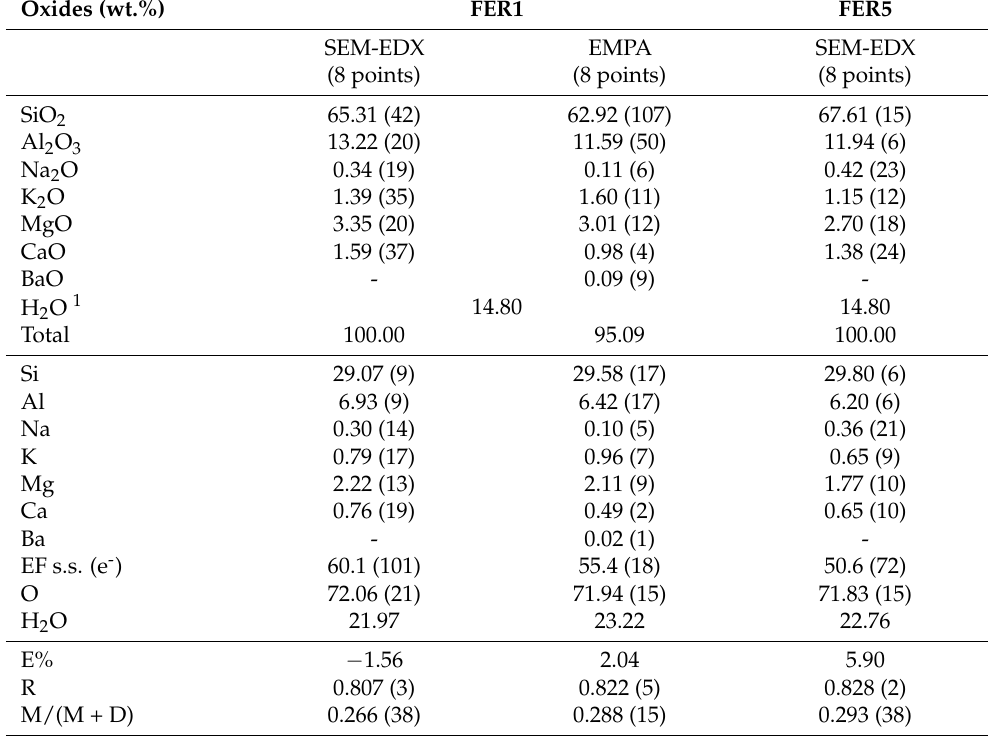
Table 2. SEM-EDX and EMPA chemical analyses of the fibrous ferrierite samples. The number of analytical points is reported in parentheses. EMPA data of FER1 indicated a FeO content of 1.97 wt.% arising from Fe-rich phyllosilicate particles sticking to the surface. For this reason, iron was not included in the calculation of the crystal-chemical